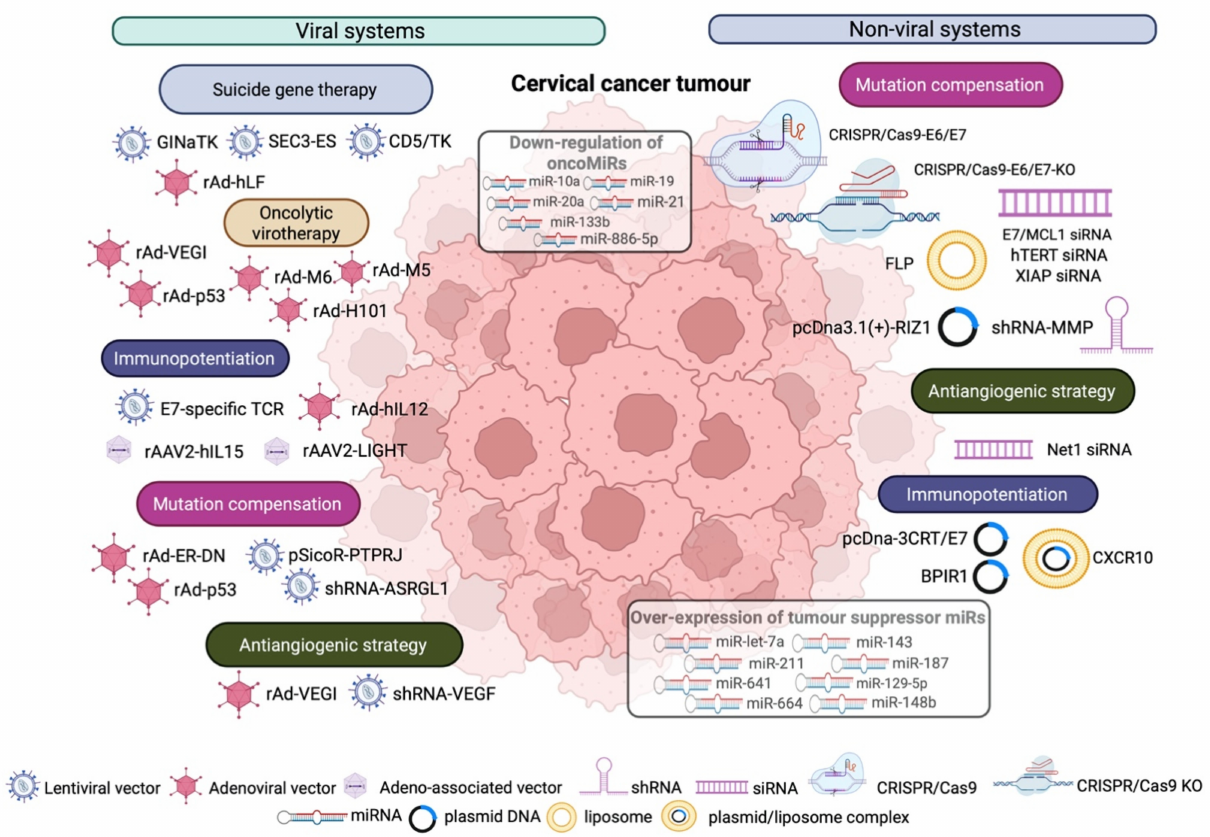
Figure 4. Gene therapy strategies for cervical cancer. They employ viral vectors, primarily adenoviral and adeno-associated viral vectors and lentiviral vectors, and non-viral systems, such as DNA plasmids, nanoparticles, CRISPR/CaS9, and shRNA/siRNA/miRNA